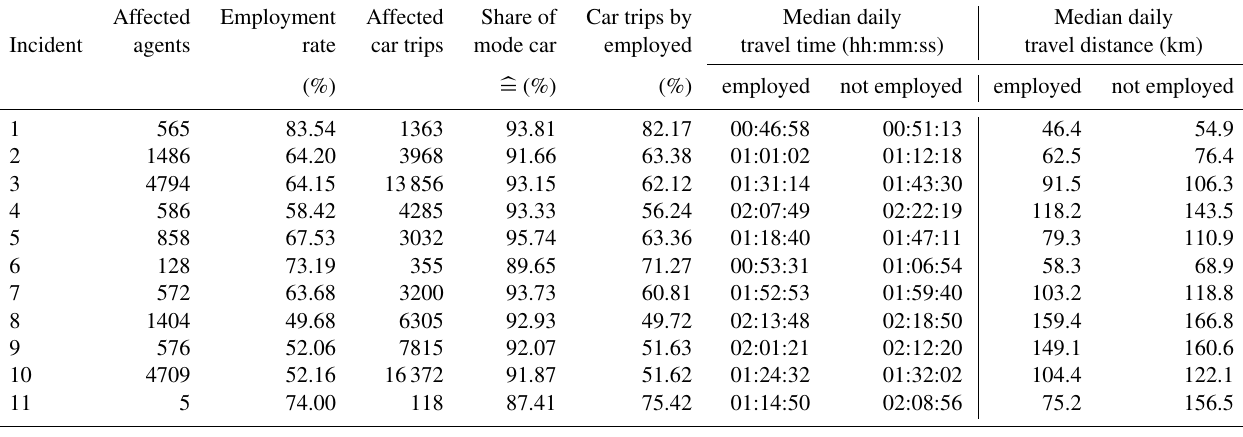
Table 2. Summary of car trip characteristics for agents in the traffic model of the undisturbed baseline scenario, to be affected by incident scenarios. Affected agents refer to those crossing the incident site at least once within their regular daily plans. Employment rate is the share of working people within this group. Affected car trips designate the number of incident site traversals by those agents in that transport mode. The share of the mode of car gives the proportion of site traversals by car relative to all traversals mentioned before (in any mode). Site traversals of incident links by car undertaken by employed people are shown as percentage in column six. Medians of daily travel time and distance are displayed for employed and not employed people, respectively, which again refer to all affected agents and their trips crossing each site.